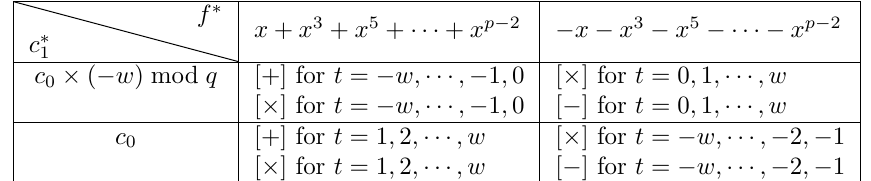
Table 2: The Mapping between ( f ∗ , c ∗ ) and Template